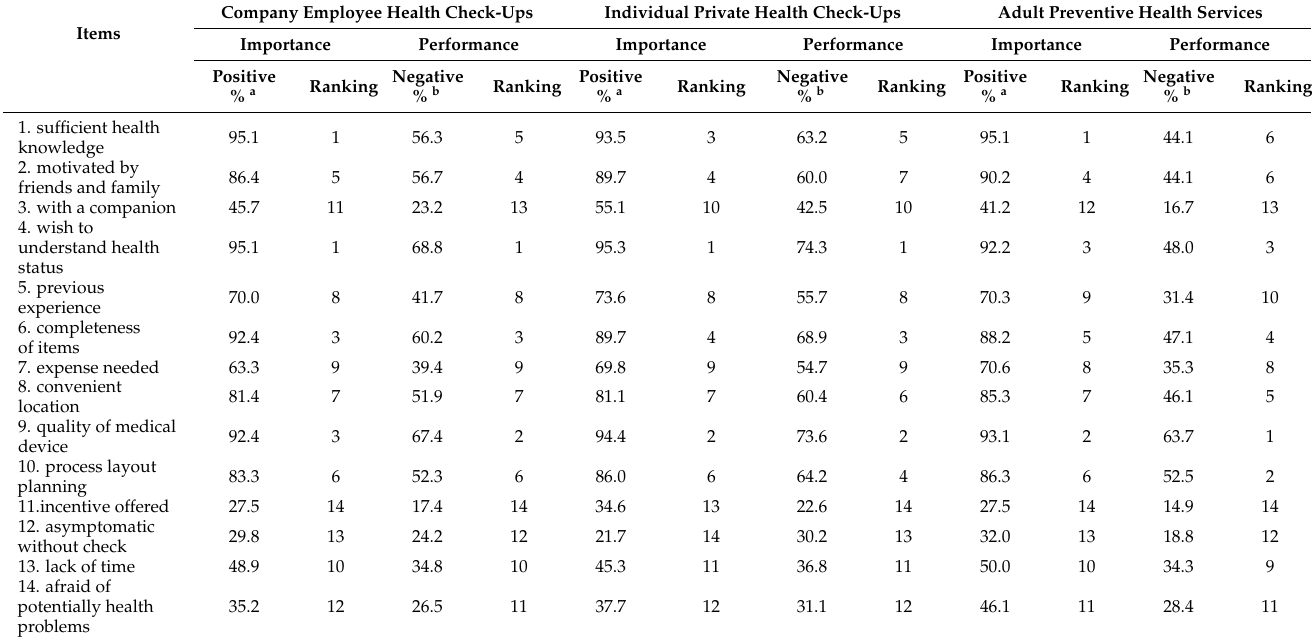
Table 2. Items affecting individuals’ utilization of health check-up programs: importance and influence on